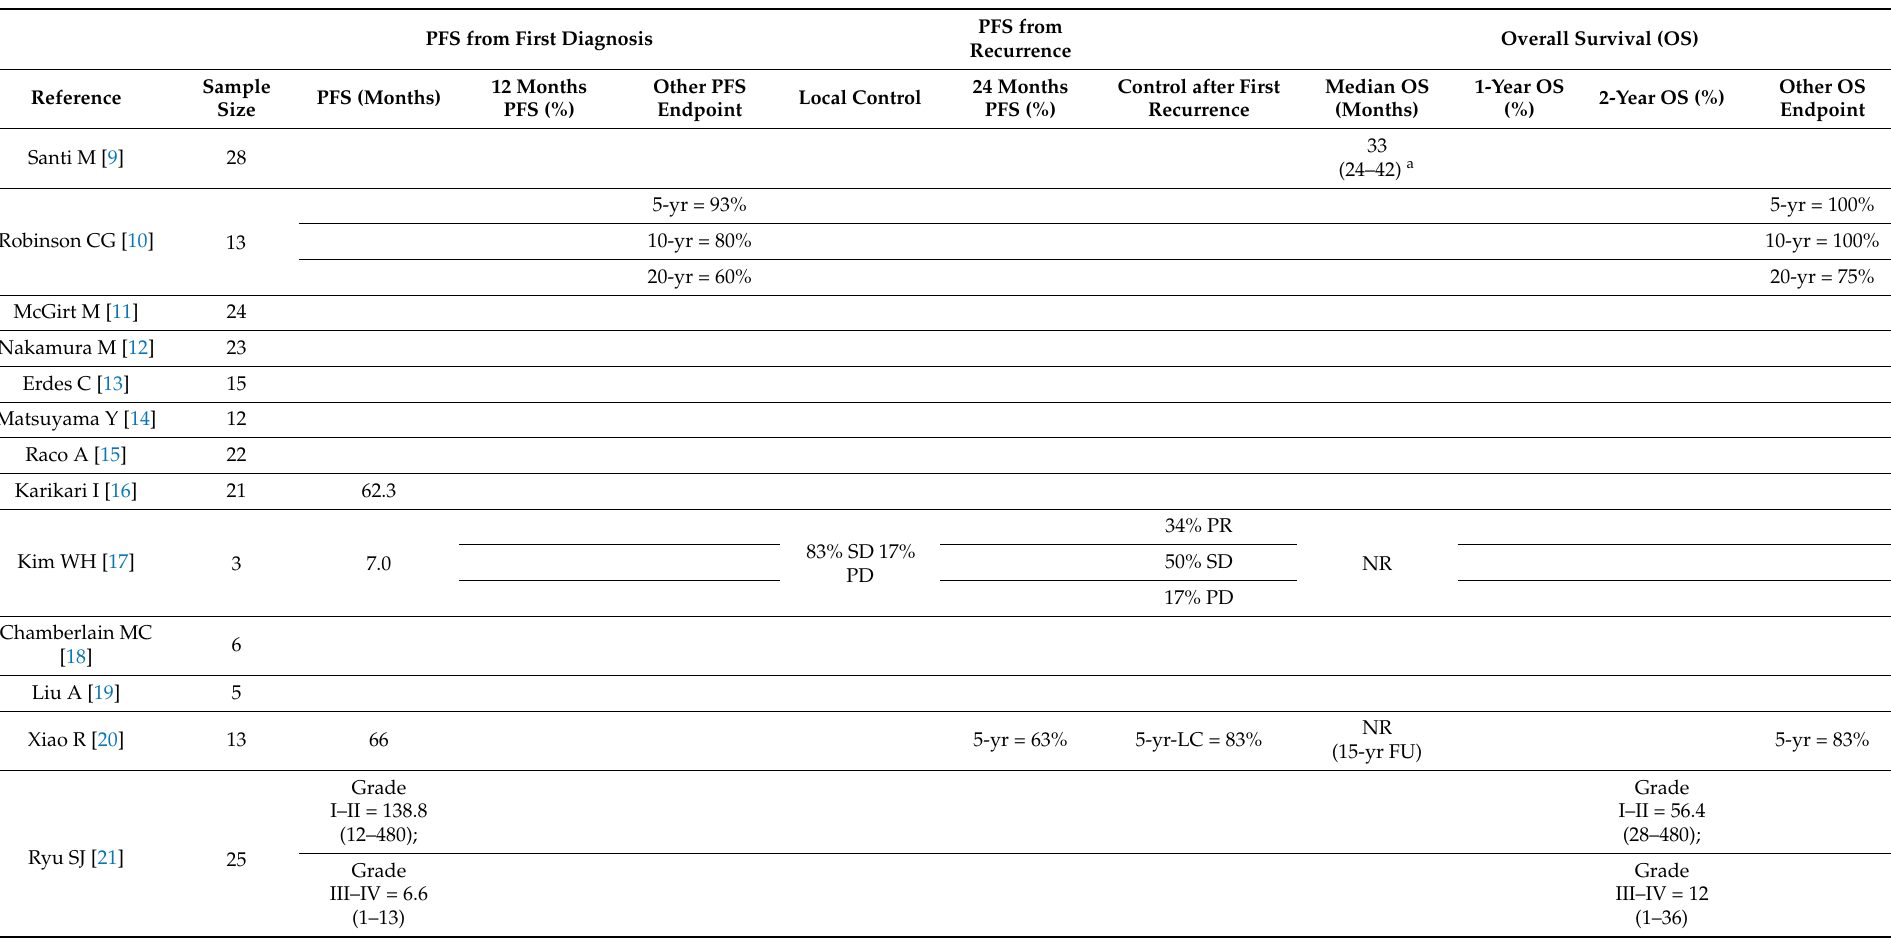
Table 2. The survival outcomes (as OS or PFS). Abbreviations: PFS = Progression Free Survival; OS = Overall Survival; Control disease: SD = Stable Disease, PR = Partial Response; PD = Progression Disease; NR = Not Reached; LC = Local Control; FU = Follow-Up; yr = year. Empty cell = Data Not Available. ( a ): overall OS (total series of 36 cases) ( b ): overall PFS (total series of 16 cases, including 6